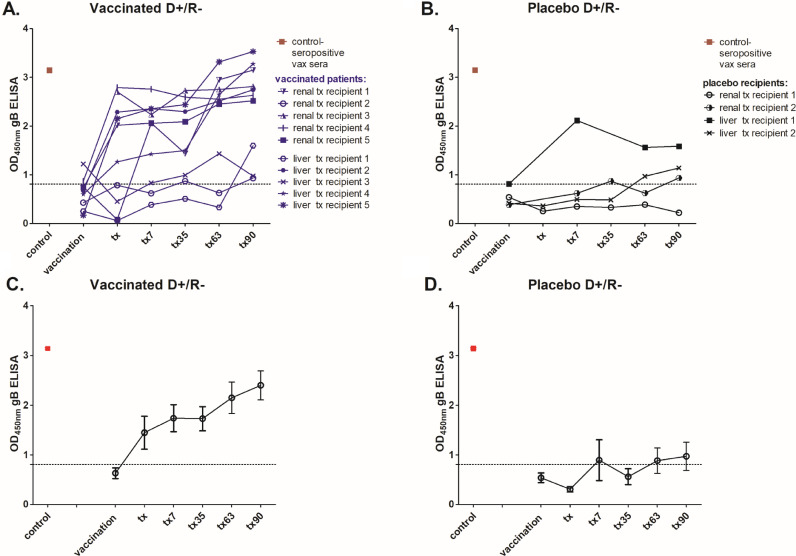
Seronegative patients who received vaccination prior to transplantation are primed to mount faster and more robust anti-gB antibody responses once challenged with the virus in comparison to delayed responses in placebo recipients.Total anti-gB antibody levels were measured by standard ELISA and are shown as follows: A) for individual vaccinees (n = 10) and B) placebo (n = 4) recipients; C-D) The average anti-gB antibody responses are presented for vaccine (C) placebo patients (D): Serum samples were collected at the time of vaccination (baseline, dotted line), time of transplantation and on days: 7, 35, 63 and 90 post-transplant. Where an individual point (in A & B) is missing a sample was not available for that timepoint for analysis. Combined sera from healthy seropositive donors (n = 6) was used as a positive control. Dashed line represents the cut off and was informed by control sera taken from healthy seronegative individuals (n = 6).